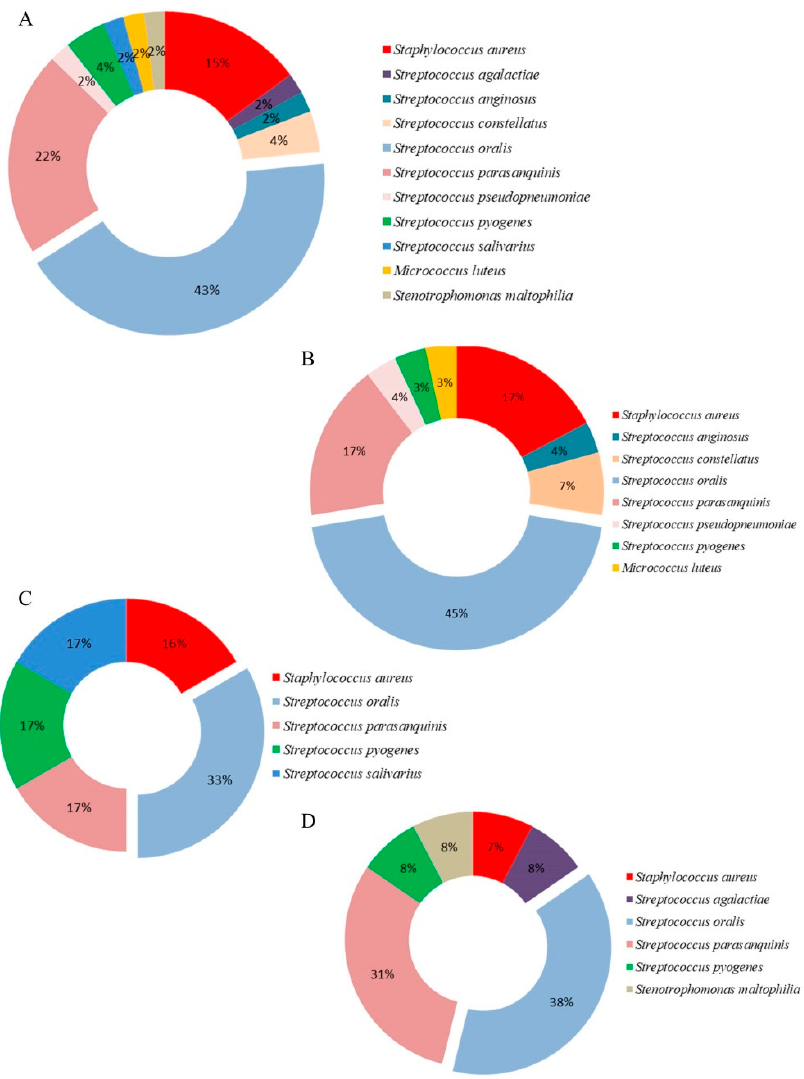
Figure 2. Percentage representation of species in postoperative samples of tonsil tissue of: ( A ) Group II patients; ( B ) Group IIa; ( C ) Group IIb; ( D ) Group IIc.